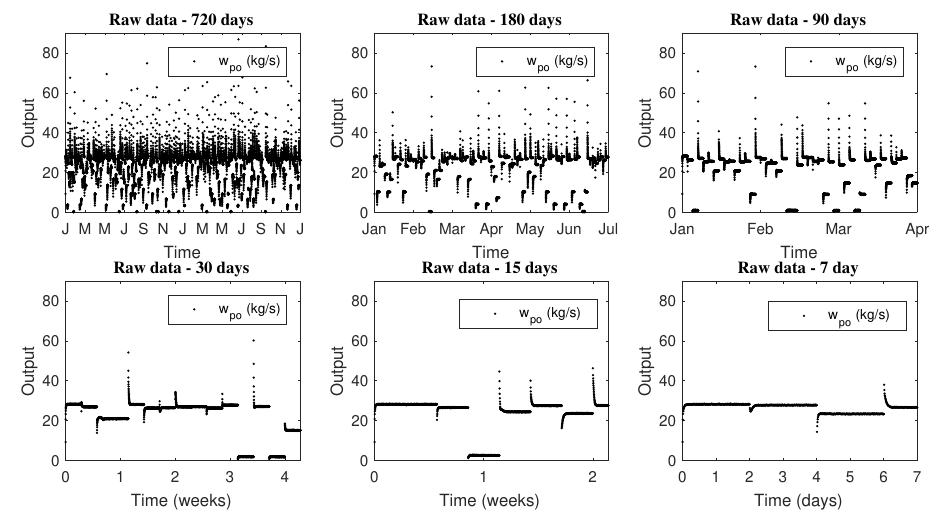
Figure 14. Raw data time serie